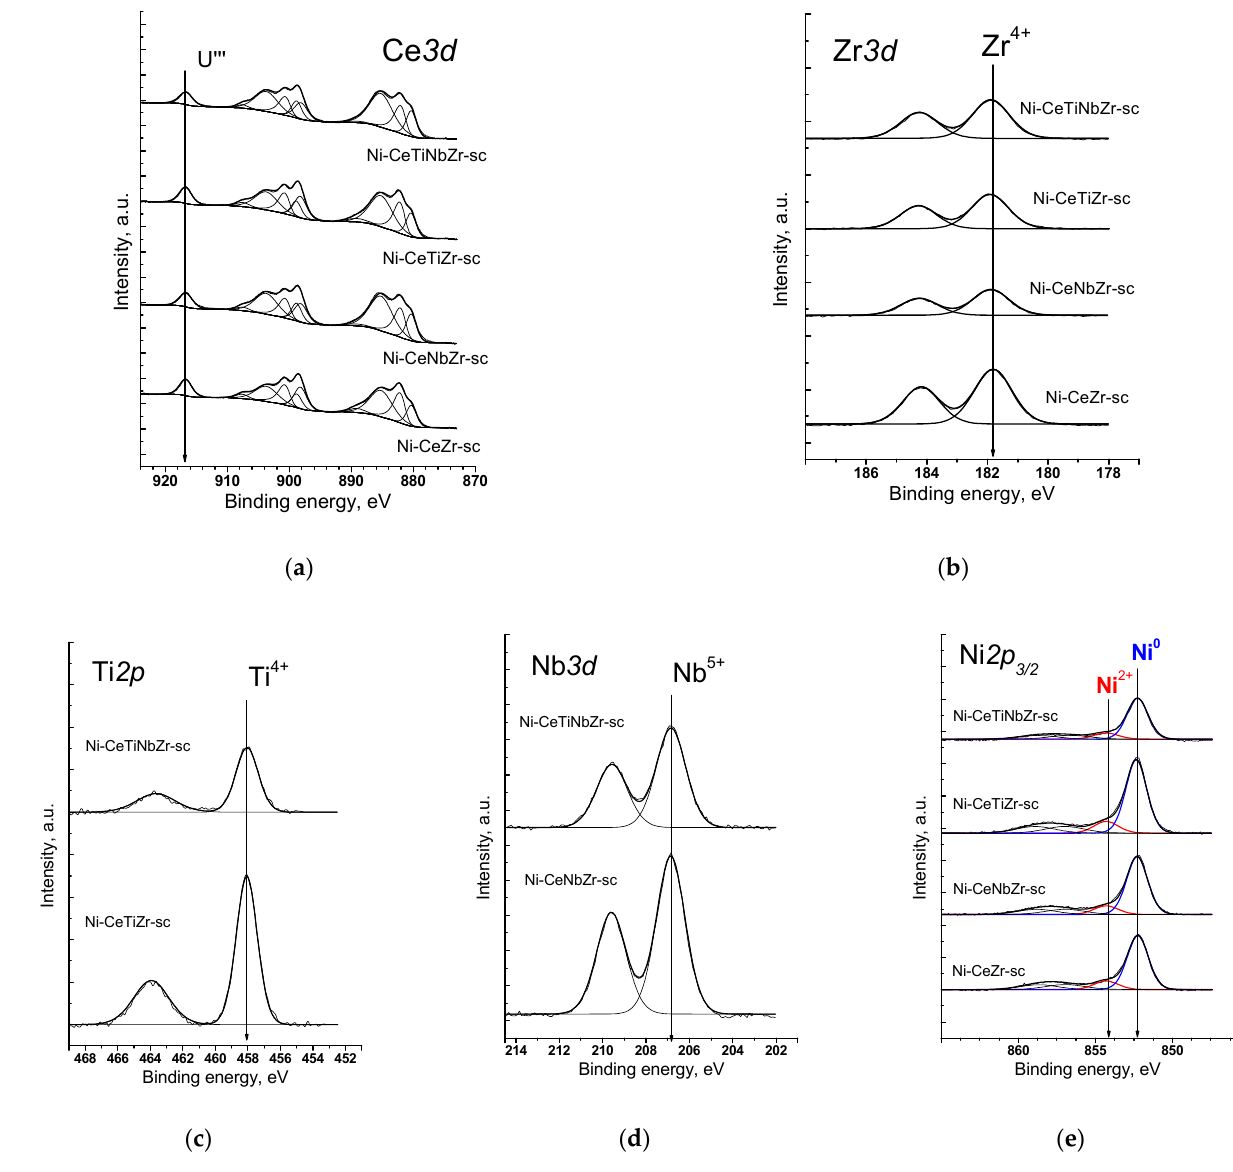
Figure 1. XPS spectra of catalysts prepared by supercritical synthesis after reduction treatment in H 2 at 450 °C: ( a ) Ce 3d spectra, ( b ) Zr 3d spectra, ( c ) Ti 2p spectra, ( d ) Nb 3d spectra, ( e ) Ni 2p 3/2 spectra. Table 3. Atomic ratios of elements in the (sub)surface layers of catalysts after reduction treatment in H 2 at 450 °C.